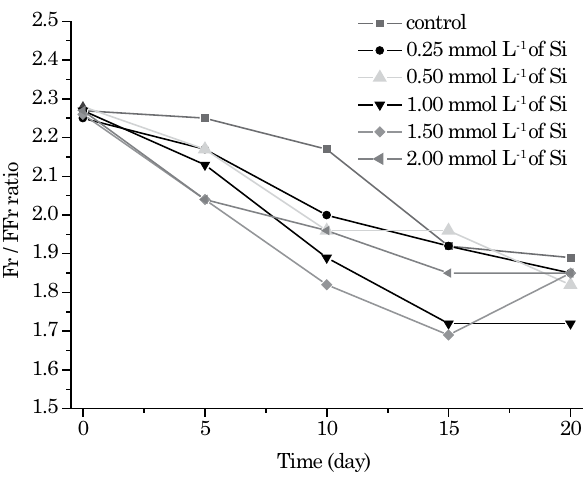
Figure 3. Spectra of the chlorophyll fluorescence ratio as a function of growing time of maize plants under increasing silicon application rates in a nutrient solution contaminated by arsenic (Fr/FFr at the F685 ηm and F735 ηm wavelengths,